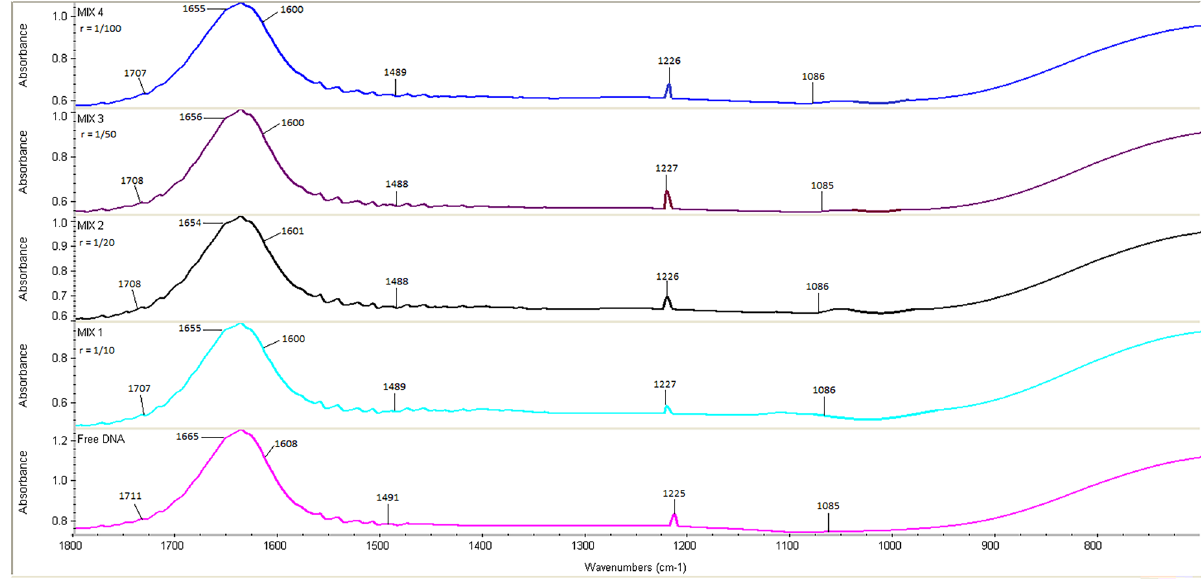
Figure 8. Stacked view of FT-IR spectra of free CT-DNA and PLB/CT-DNA ratios of 1/10, 1/20, 1/50, and 1/100 in the region of 1800–700 cm −1 .